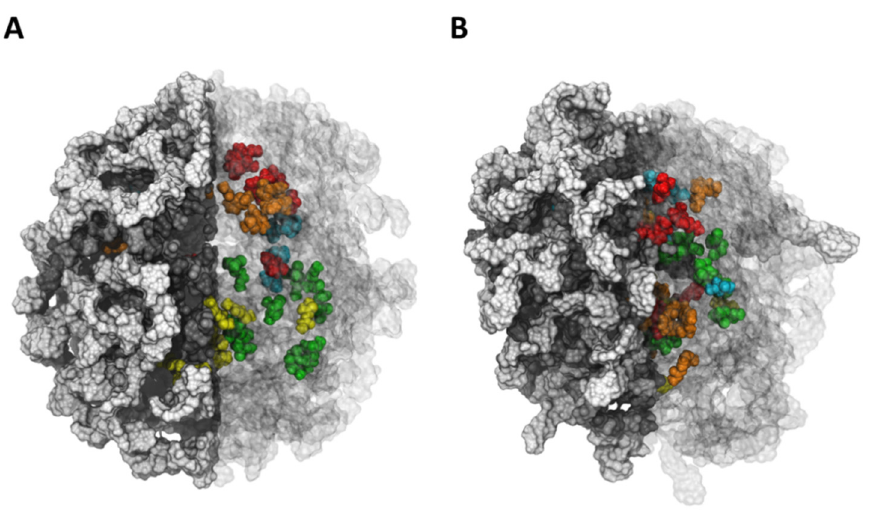
Figure 4. The nanoparticle shape of ALG-CT (at pH 7) at the ( A ) beginning (0 ns) and ( B ) final simulation time (100 ns). The compounds are shown in different colors. The ALG and CT chains are represented in gray and white, respectively. The particle was divided for its best representation. The left half shows an opaque representation, while the right half shows the transparent one to be able to visualize the compounds within the particle.